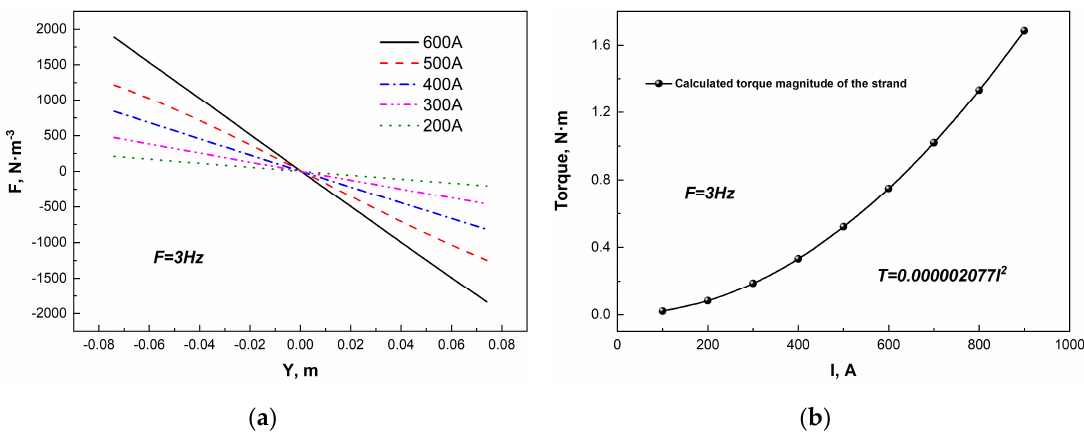
Figure 13. ( a ) Distribution of time-averaged electromagnetic force along the center plane of the stirrer; ( b ) Electromagnetic torque of strand under different current intensities.